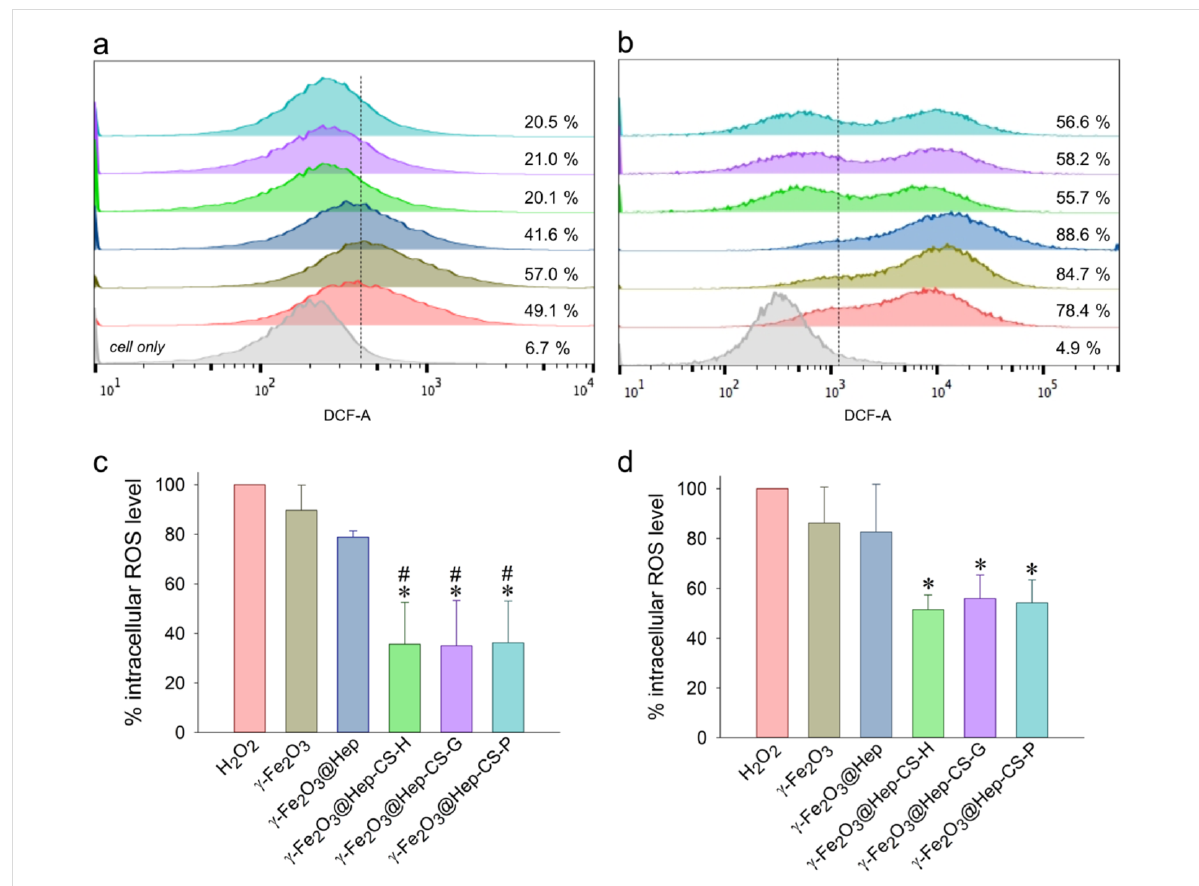
Figure 7: Flow cytometry analysis of the antioxidant activity of the phenolic compound-modified particles based on intracellular ROS levels in (a, c) L-929 and (b, d) LN-229 cells. (a, b) The representative fluorescence shift was derived from Figure 6. (c, d) Intracellular ROS levels were normalized to the H 2 O 2 levels. * , # p < 0.05 compared to the corresponding results with H 2 O 2 and γ -Fe 2 O 3 @Hep, respectively. Values are shown as the mean ± SE ( n = 3–4).